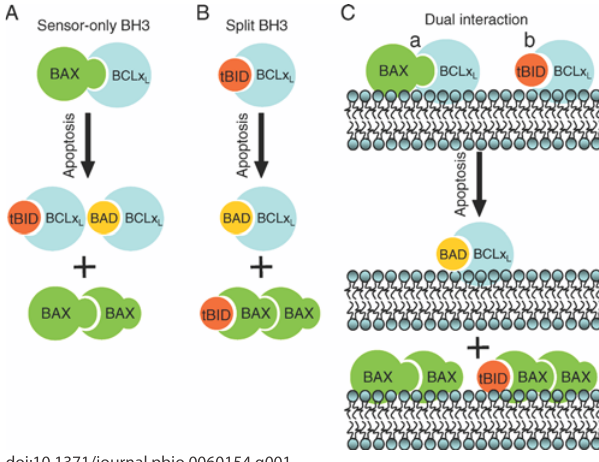
Figure 1. Schematic Models to Explain the Functional Relationships between Bcl-2 Family Proteins Depicted are the anti-death Bcl-2-type protein Bcl-XL, the pro-death protein Bax, and the BH3-only proteins Bid (N-terminally truncated Bid or tBid, an activator- or sensor-type), and Bad (sensor-type BH3-only protein). (A) In the sensor-only model, all BH3-only proteins serve to inactivate Bcl-2-like cell death inhibitors, which when released allow activation and oligomerization of Bax. (B) In the split BH3 model, some BH3-only proteins act upstream of Bcl-2-types, while others act downstream. The BH3-only protein tBid is sequestered by Bcl-XL, and when tBid is displaced by sensor-type BH3-only protein Bad, tBid is freed to activate Bax, which in turn oligomerizes in the membrane to facilitate release of pro-apoptotic proteins. (C) In the dual interaction model put forth by Billen and colleagues, Bcl-XL can interact with either Bax or tBid in the same